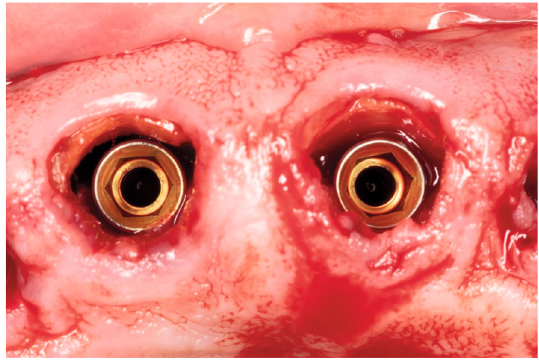
Figure 1: Image of the roots before the treatment.